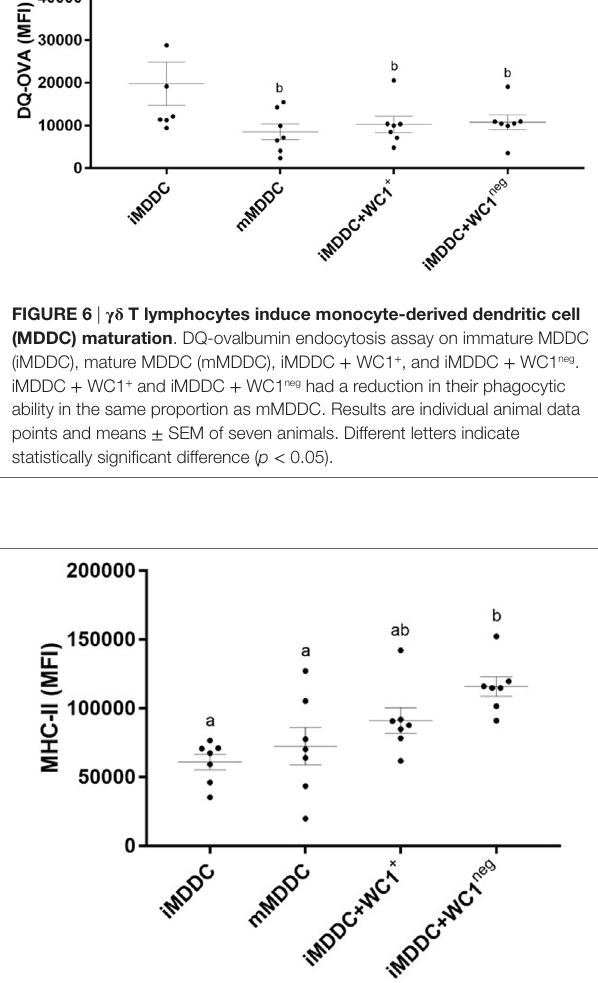
FigUre 7 | Wc1 neg γδ T lymphocytes increase the antigen presenting ability of immature monocyte-derived dendritic cells (iMDDcs) . Median fluorescence intensity of major histocompatibility complex-II on iMDDCs, mature MDDCs, iMDDCs + WC1 + , and iMDDCs + WC1 neg . Results are individual animal data points and means ± SEM of seven animals. Different letters indicate statistically significant difference ( p < 0.05).